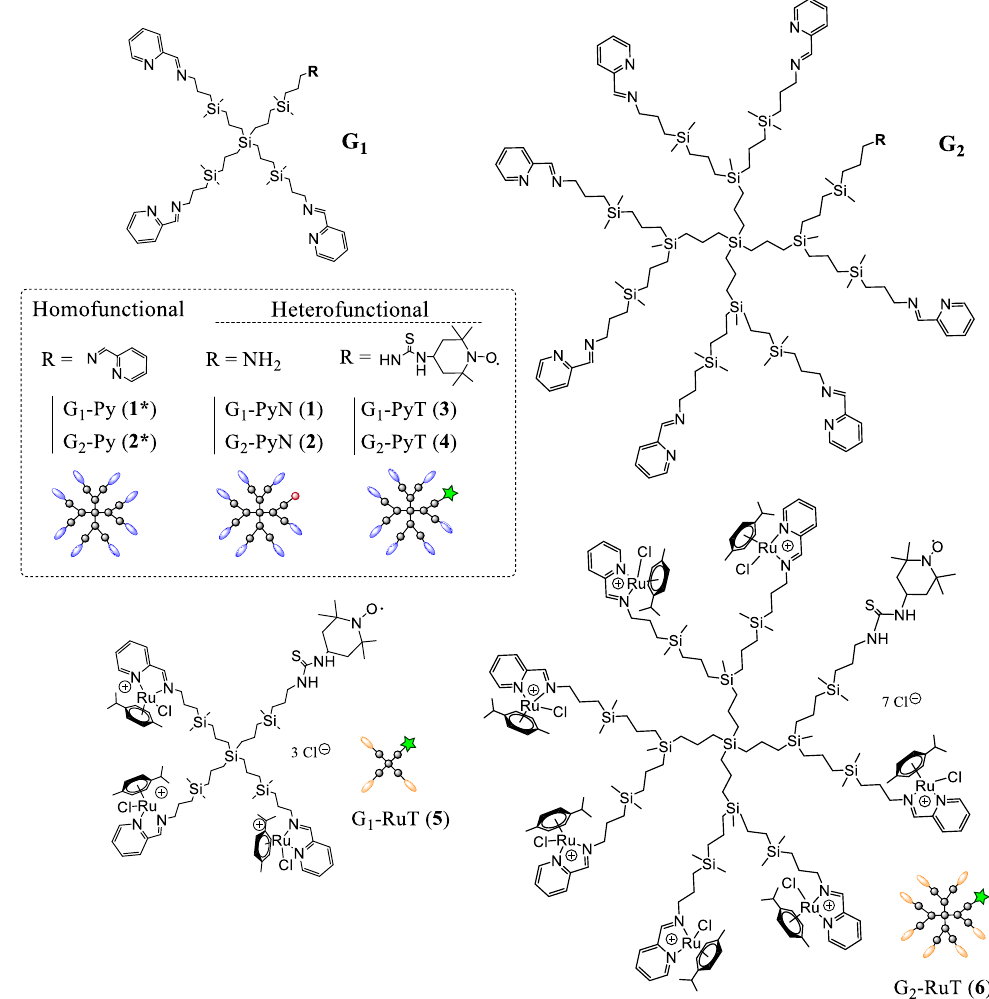
Figure 1. Structural representation of dendrimers and metallodendrimers used in the electron paramagnetic resonance (EPR) study. Homofunctional dendrimers: G n -Py ( 1* , 2* ); heterofunctional dendrimers: G n -PyN ( 1 , 2 ) and G n -PyT ( 3 , 4 ); heterofunctional metallodendrimers: G n -RuT ( 5 , 6 ). For comparison, iminopyridine homofunctional dendrimers G n -{[NCPh( o -N)] m (G n -Py; n = 1, m = 4 ( 1* ); n = 2, m = 8 ( 2* ) and the mononuclear counterpart n = 0, m = 1 ( 0* )) were used in EPR evaluation. Overall, these dendrimers provided information about the effect of dendritic generation